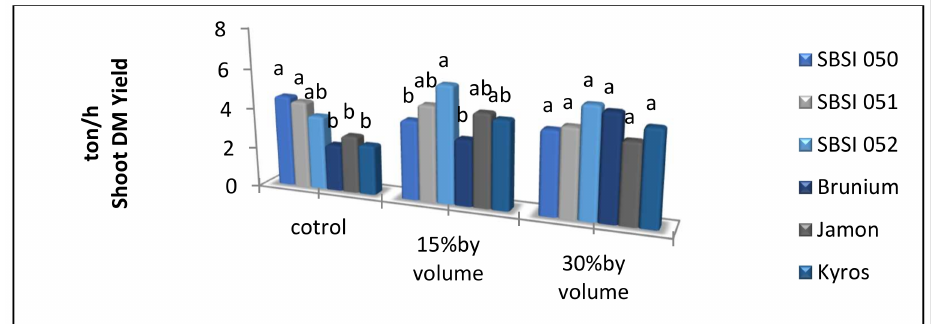
Figure 4. The interaction effects of genotype × methanol on shoot dry matter yield. Means followed by the same letter(s) is/are not significantly differ at 5% level of